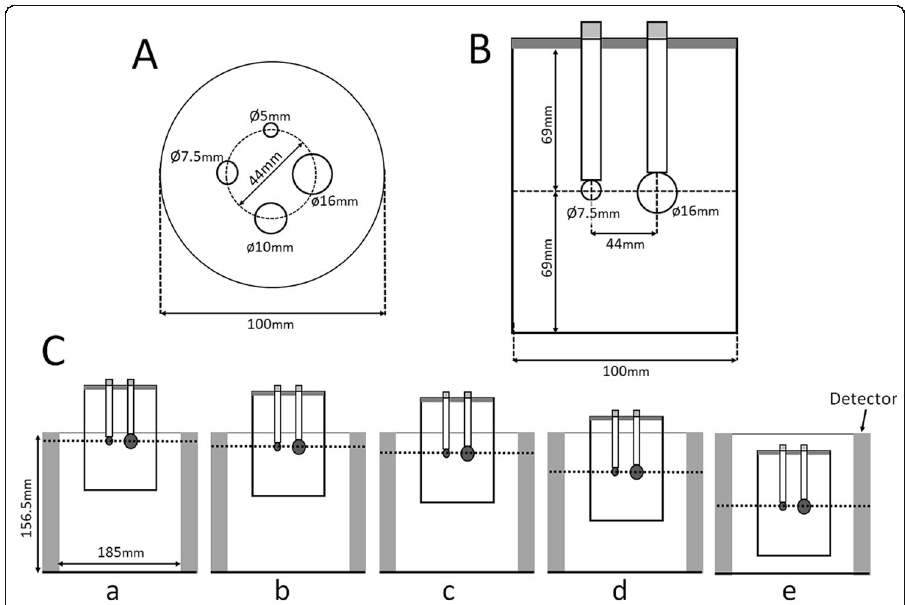
Fig. 1 Cross-sections of the phantom with dimensions. A transverse plane view ( A ) and a lateral view ( B ) of the breast phantom in which the spheres were arranged. C Relationship between the PET detectors and the phantom (lateral views). The distances from the upper edge of the detector were 8 mm (a), 13 mm (b), 19.5 mm (c, depth of 1/8), 39.5 mm (d, depth of 1/4), and 78 mm (e, depth of 1/2, the centre of the the bottom edge of the detector, only the chest wall side of the detector was evaluated. Sphere placement at each position in the detector was confirmed visually and by meas- urement on the image. A three-dimensional list-mode dynamic row-action maximum- likelihood algorithm (LM-DRAMA) was applied for the reconstruction of a dbPET image. DRAMA has been shown to achieve fast converge with a reasonable signal-to- noise ratio with a single iteration and 128 subsets by including the relaxation parameter λ , which was defined by the subset number and the relaxation control parameter of β [18, 19]. In this study, the dbPET images were reconstructed using LM-DRAMA with β = 20, the matrix size in the transverse view 236 × 200 × 236, and a post-reconstruction smoothing Gaussian filter (1.17-mm FWHM) without the time-of-flight (TOF) al-